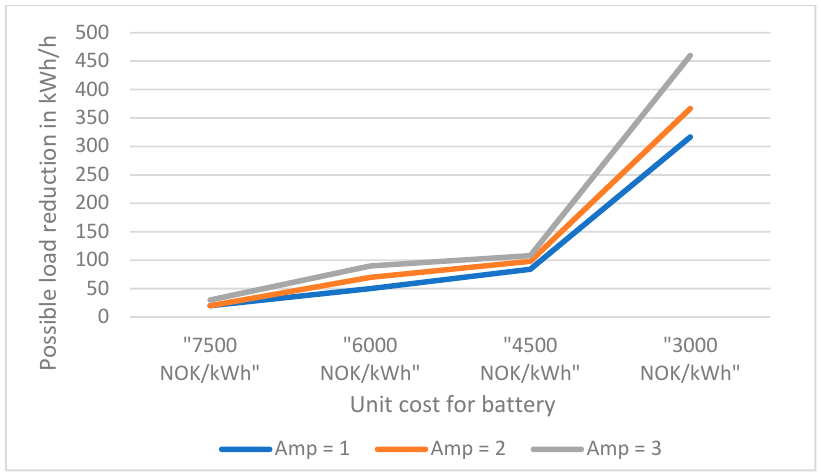
Figure 7. Possible load reduction as a function of the demand (amplification factors 1, 2, and 3) and the battery cost.